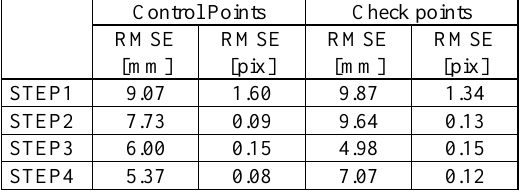
Table 12. Metrics provided by Photoscan